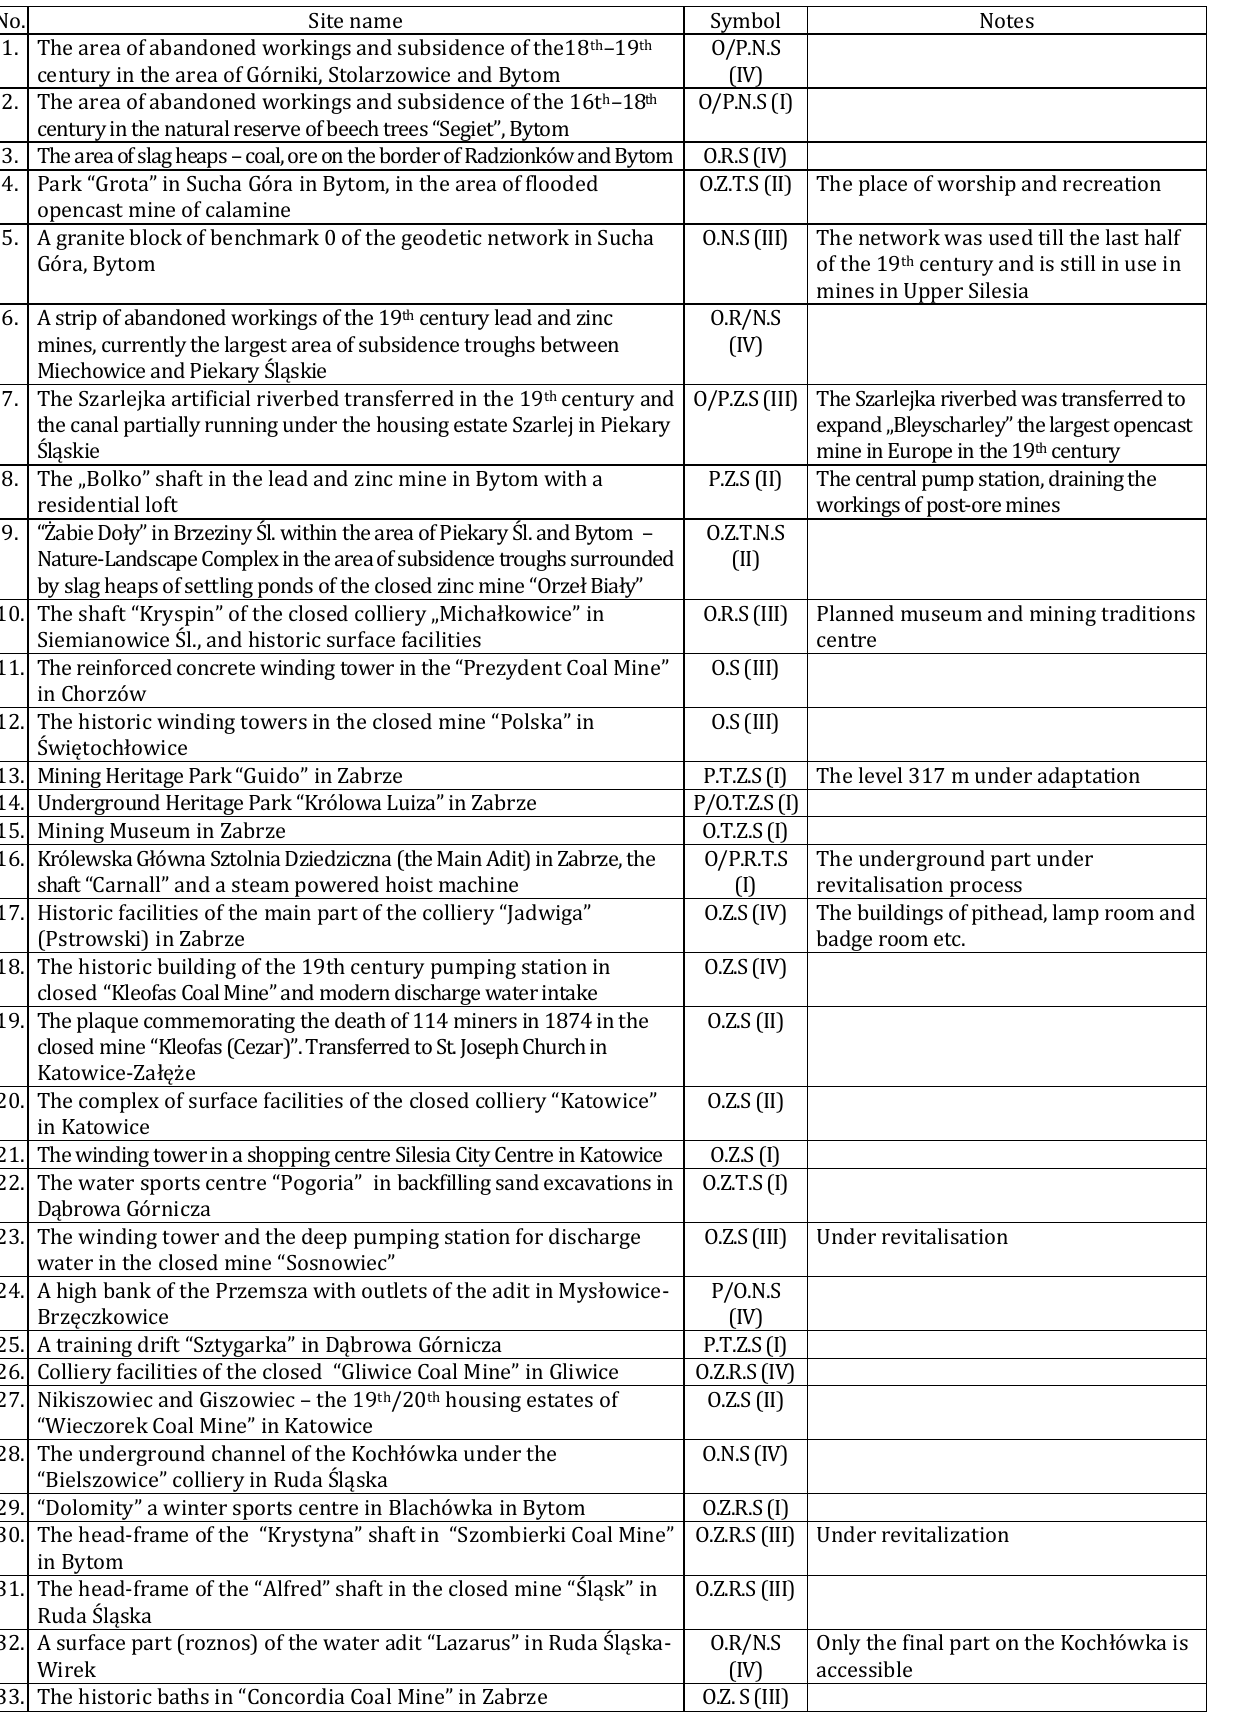
Table 1. Classification of post-industrial heritage sites within the area of the Katowice